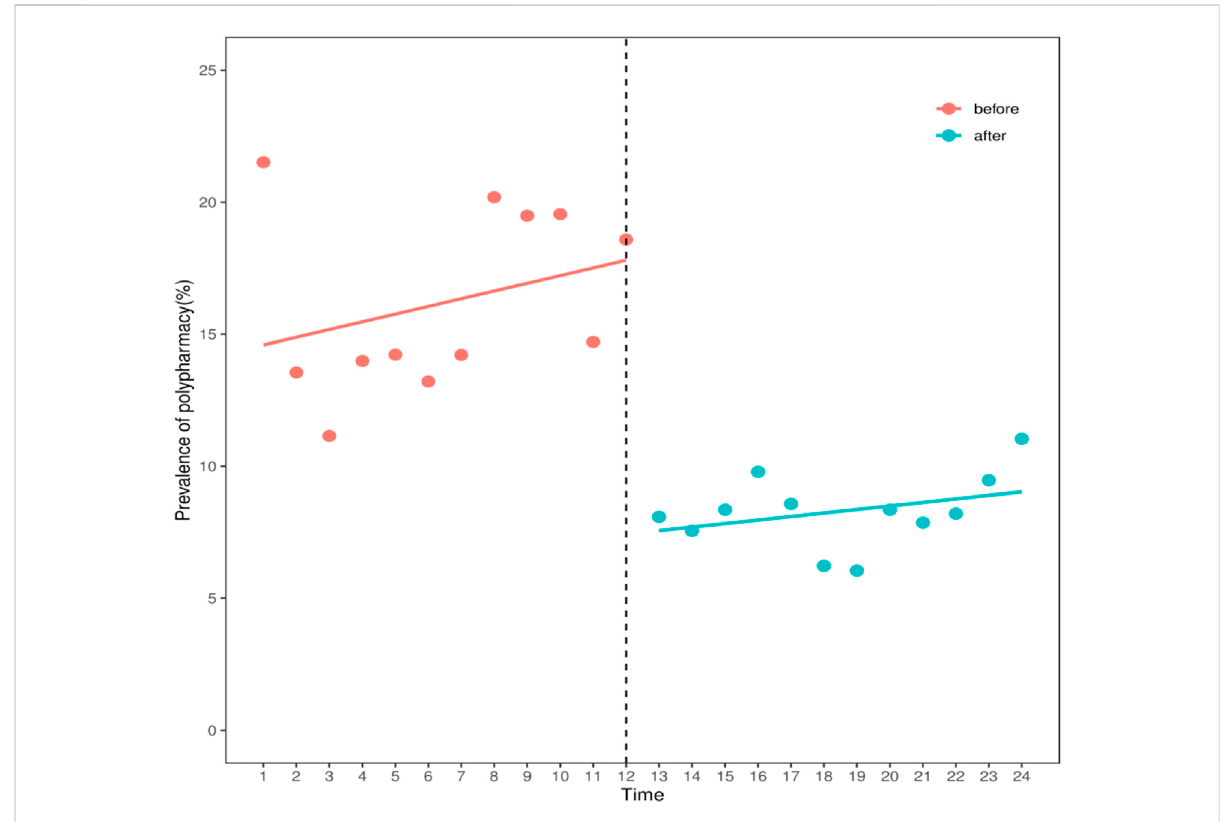
FIGURE 1 The prevalence of polypharmacy in Chengdu, 2016 – 2021.